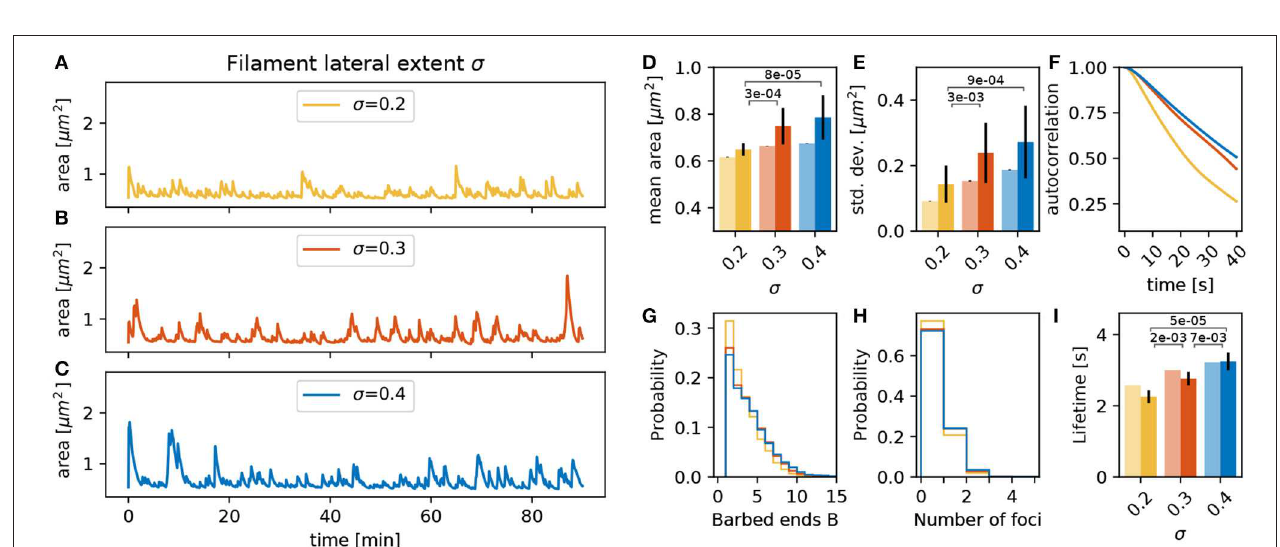
FIGURE 5 | Varying the branching rate amplitude φ . (A–C) Evolution of the spine head area over time for different values of φ : (A) φ (D) Temporal mean of the spine head area. Light bars correspond to values from single 90 min simulations (standard deviations obtained from 50-fold bootstrap). Full colored bars and errors correspond to the mean and standard deviation over fifteen 15 min simulations. The p -value for significant Welch-tests is indicated. (E) Standard deviation of the spine head area over time. (F) Autocorrelation functions for the area fluctuations in the 90 min simulations. (G) Relative frequency of the mean number of barbed ends per focus over all simulation time-steps from (A–C) . (H) Relative frequency of the number of actin polymerization foci. (I) Mean lifetime of a focus.